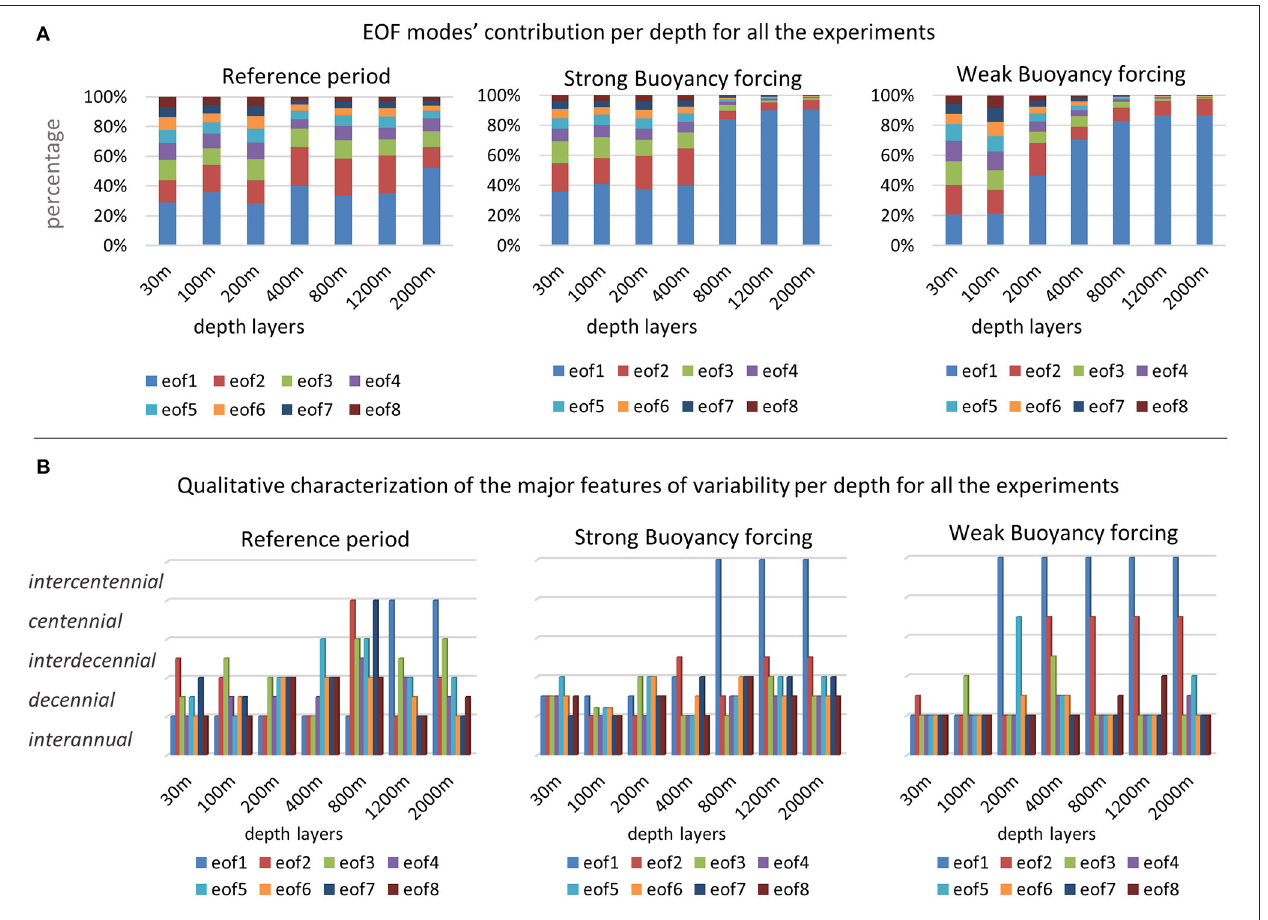
FIGURE 8 | (A) Empirical orthogonal function (EOF) mode contribution and (B) qualitative characterization of the dominant temporal variability of the first eight EOF modes of density variability at all depths for the three experiments (reference buoyancy forcing, SBF, and